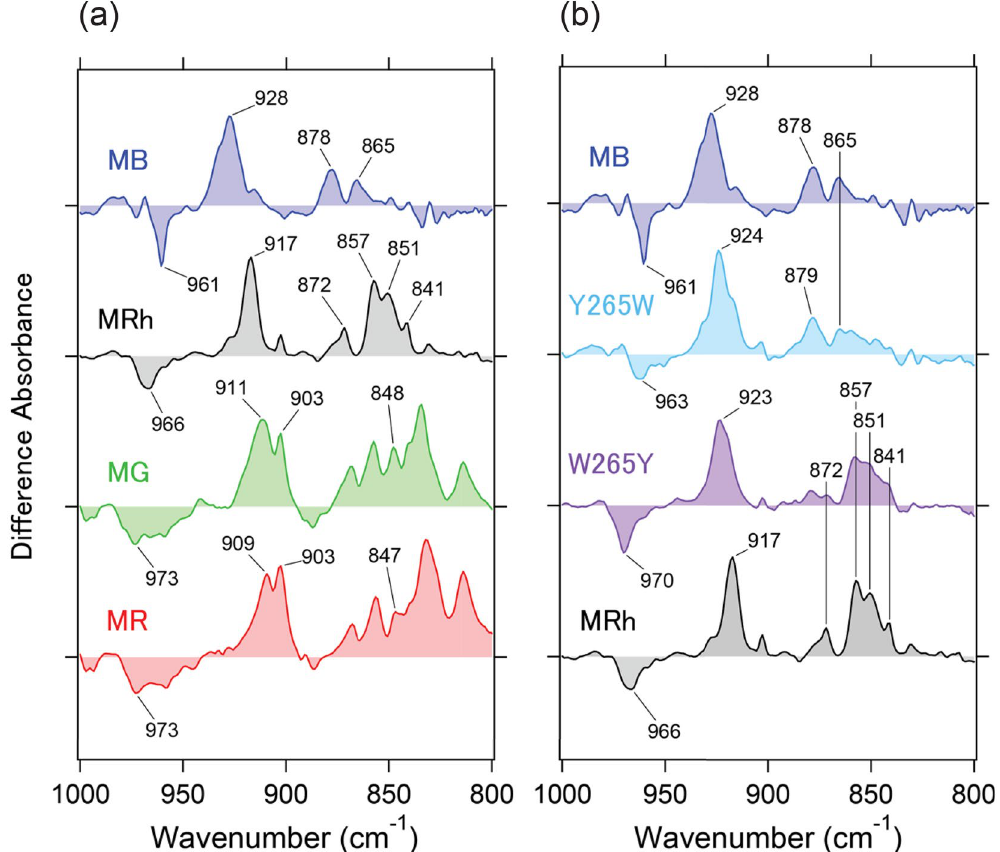
Figure 2. Spectral comparison of the mutant protein in the 1000–800 cm − 1 region. ( a ) Expanded spectra from Fig. 1 in the 1000–800 cm − 1 region. One division of the y-axis corresponds to 0.0009 absorbance units. ( b ) Light-induced all- trans minus 11- cis difference FTIR spectra of MB, MB-Y265W, MRh-W265Y and MRh in the 1000–800 cm − 1 region measured at 77 K in D 2 O. One division of the y-axis corresponds to 0.0009 absorbance